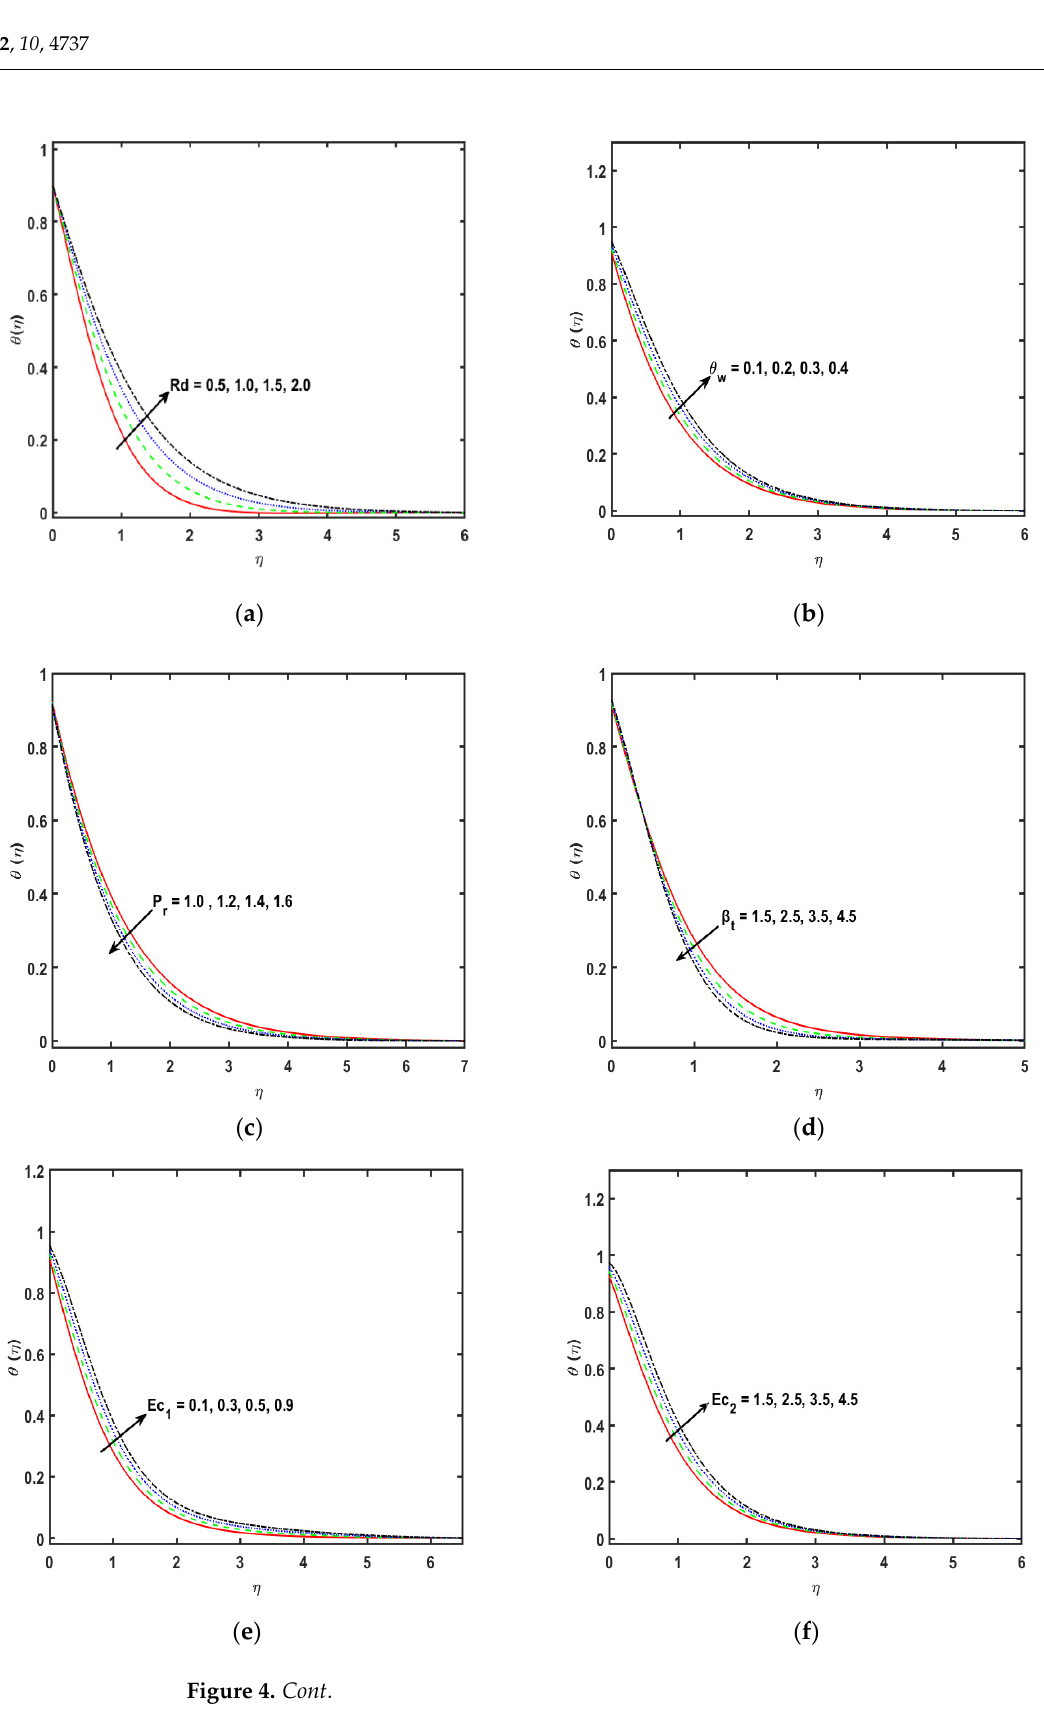
( h ) Figure 4. ( a – h ): Variation in 𝑅 (cid:3031) , 𝜃 (cid:3050) , 𝑃 (cid:3045) , 𝛽 (cid:3047) , 𝐸 (cid:3030) (cid:3117) , 𝐸 (cid:3030) (cid:3118) , 𝛿 and 𝑆 (cid:2869) , respectively. ( a )